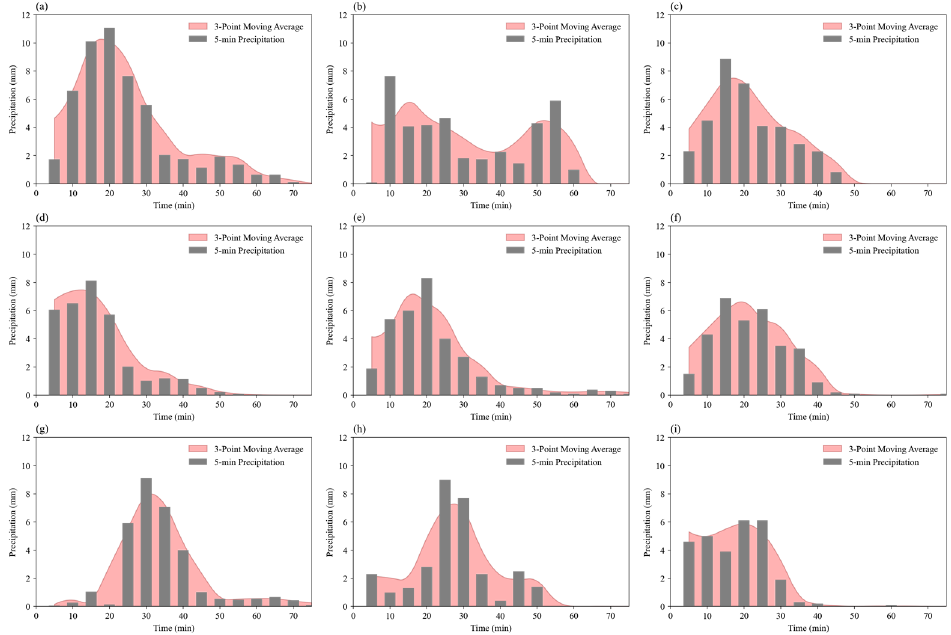
Figure 9. Storm patterns of the 9 maximum rainfall events lasting about 60 min in Nanjing ( a – i ).